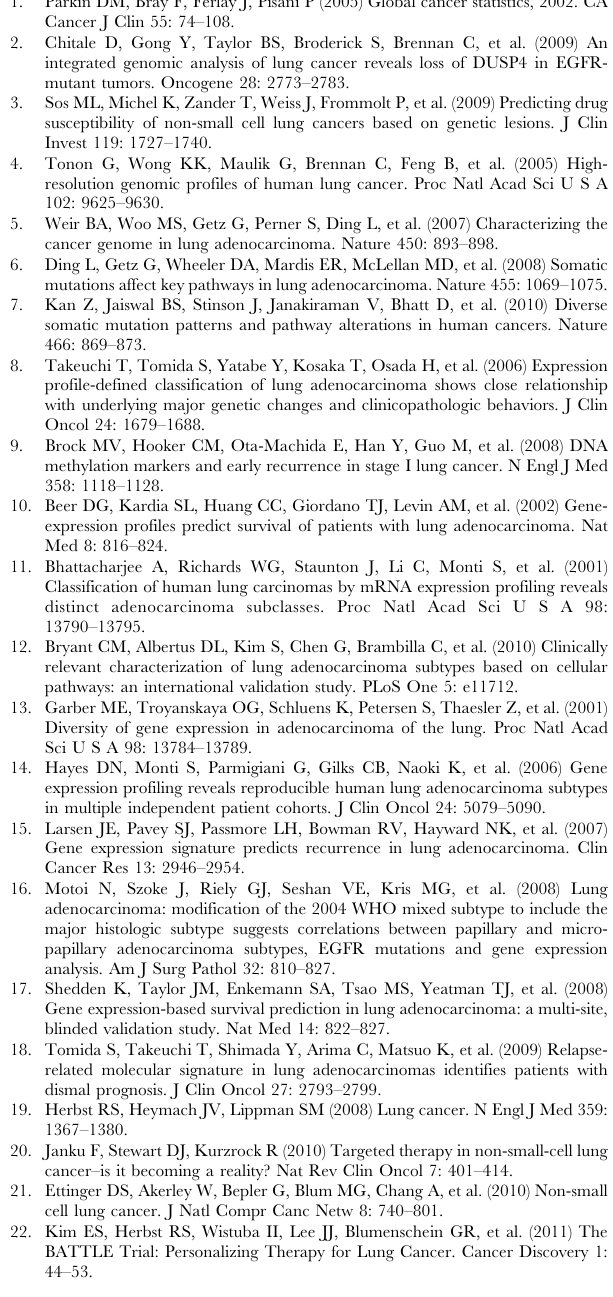
completely contained in the Magnoid versus normal sites (83% and 88%,